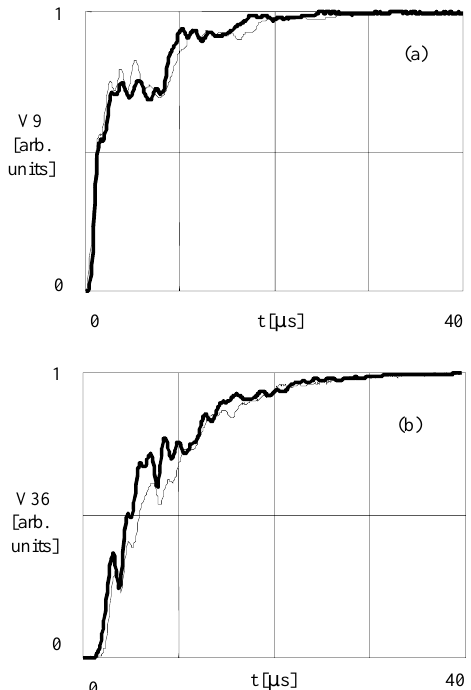
FIG. 9. (a) Transient in cell No. 9: computed (bold line), measured (standard line). (b) Transient in cell No. 36: com- puted (bold line), measured (standard line).